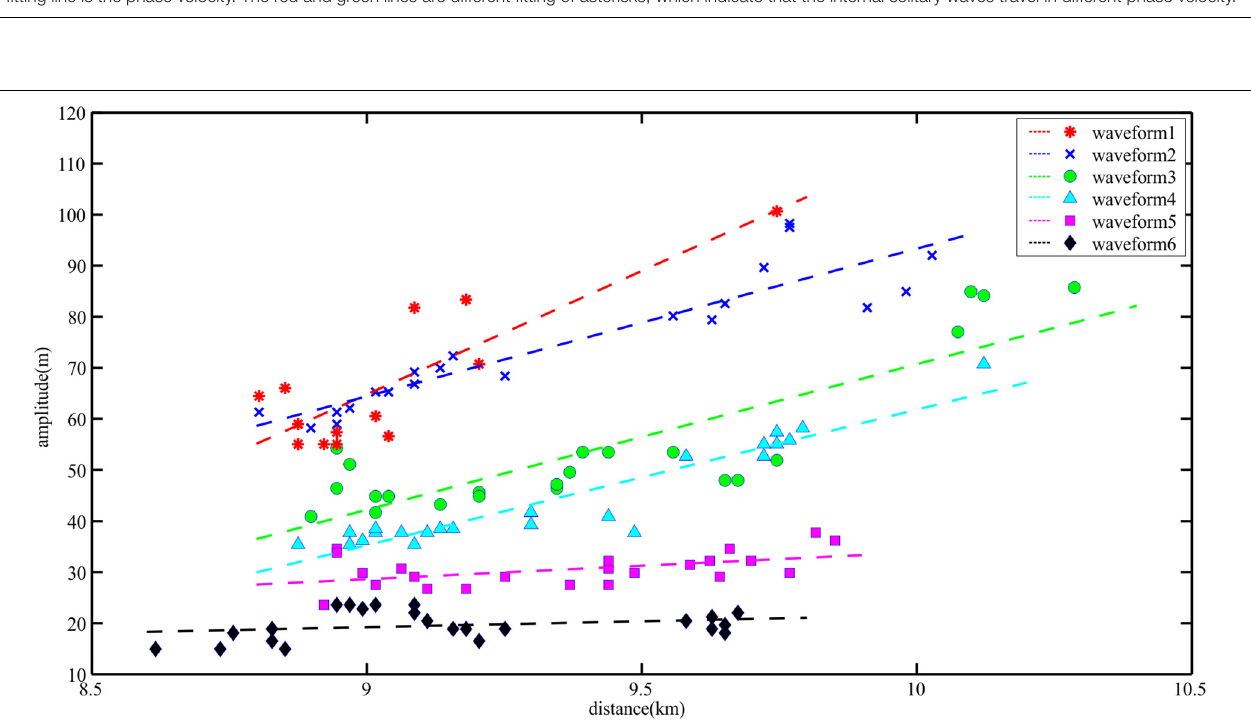
FIGURE 8 | The change in amplitudes of the six waveforms. The amplitudes picked from different waveform are shown by colored scatters. The lines are linear fitting of the marks with same color. The meaning of each colored mark is shown in the upper right legend. The internal solitary wave is moving forward along the X